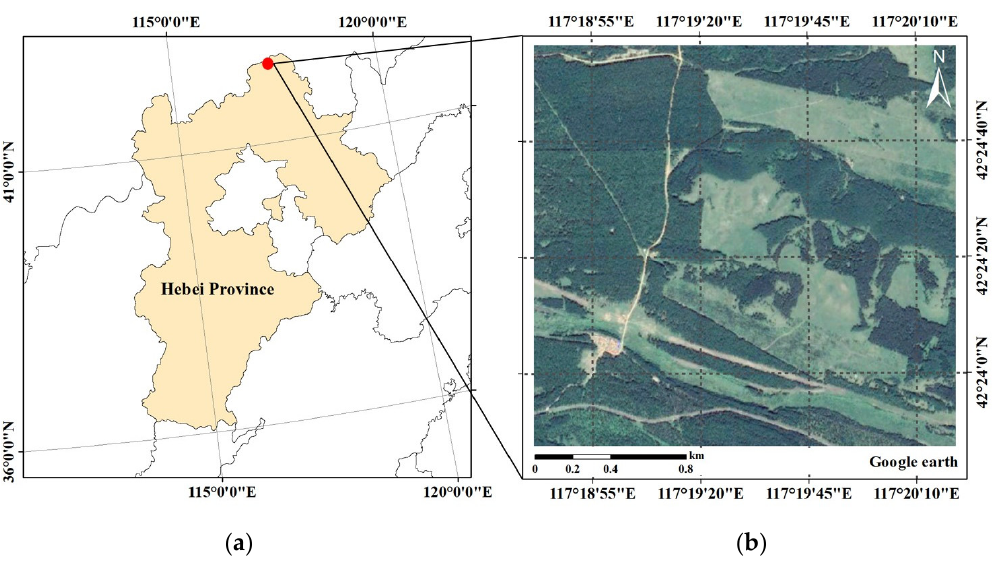
Figure 5. Location and optical image of the study area: ( a ) Location of the study area; ( b ) Google Earth true color optical image of the study area.